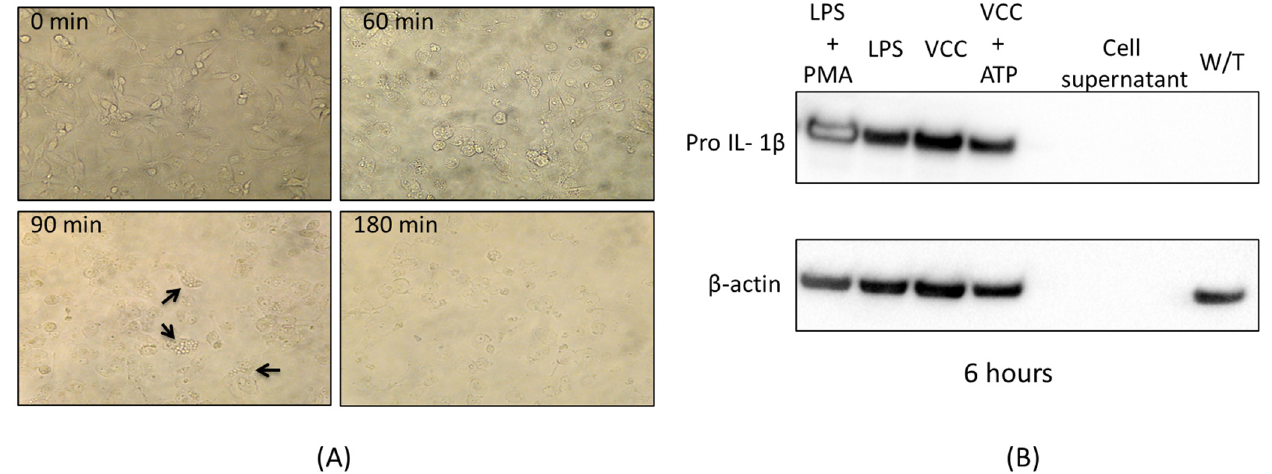
Figure 1. Standardization of responsive concentrations of VCC. A restricted concentration of VCC (40 pg/mL) induces pro-IL-1 β after 6 h of treatment without cytoplasmic vacuolization in differen- tiated THP-1 macrophages. ( A ) Chronological sequence by inverted optical microscopy. The cells were treated with 40 pg/mL toxin and later monitored (0, 60, 90 and 180 min) during incubation and photographed from an inverted optical microscope (40× Olympus IX71). Black arrows indicate a few characteristic vacuoles at 90 min; yet, this is not considered a vacuolating effect (where at least 50% of the cells are vacuolated). The results shown were arbitrarily chosen, but they are representative of three independent experiments. ( B ) Western blot showing Pro IL-1 β by treatments with 40 pg/mL of VCC after 6 h of incubation with no vacuolating effect. The expression of pro IL-1 β protein with different treatments (LPS + PMA, LPS, VCC, VCC + ATP) at 6 h was measured by a western blot assay. WB of the β -actin protein level is an internal control.